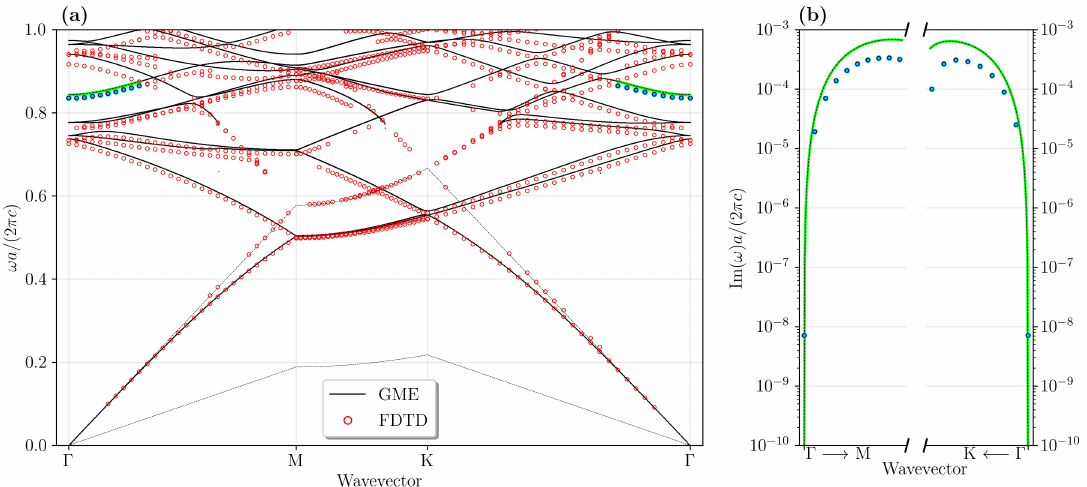
Figure 3. ( a ) Real part of the GaN odd modes (transverse magnetic (TM)-like) bandstructure calculated with the GME and the FDTD methods. The parameters chosen for these simulations are: n = 2.31, d / a = 0.337 and r / a = 0.206. The k -space region surrounding the SH mode at the Γ point is highlighted. ( b ) Imaginary parts of the eigenmodes highlighted in the bandstructure ( a ). The vanishing Im ( ω ) indicates the presence of a bound-state in the continuum (BIC) at the Γ point, both from GME and FDTD